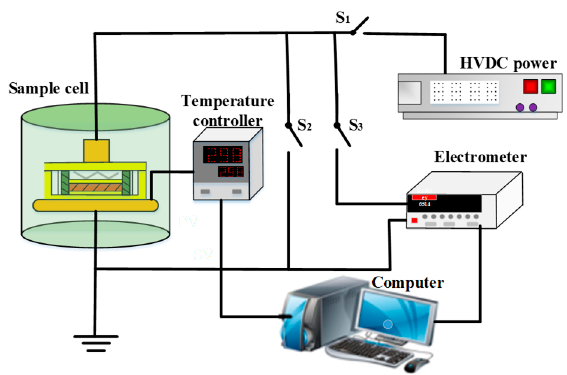
Figure 3. Schematic of thermally stimulated depolarization current (TSDC) measurement.